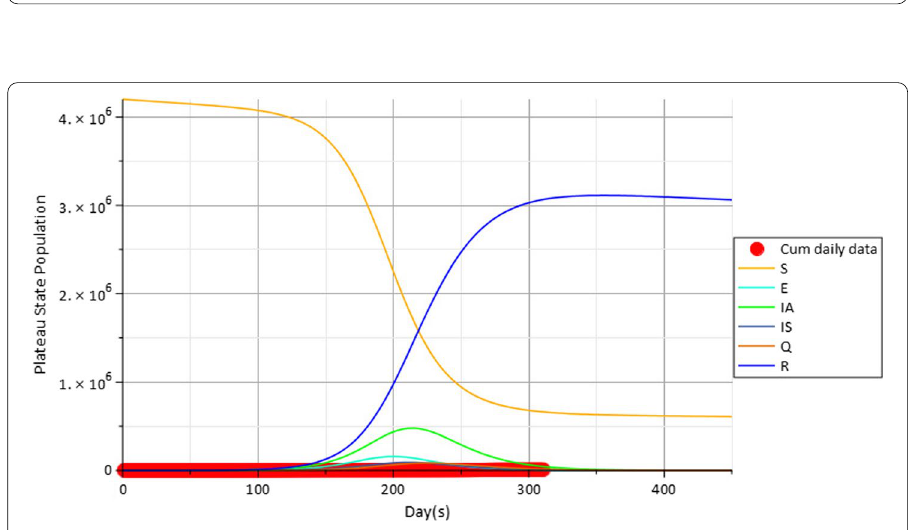
Fig. 10 The S E I A I S Q R and cumulative daily infectious individuals from NCDC